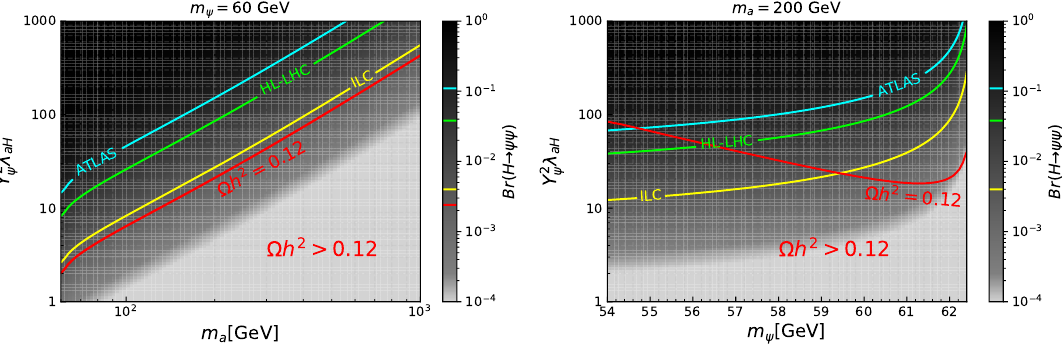
Figure 15. Potential of the current LHC, HL-LHC and the ILC colliders to probe the loop induced branching ratio of Higgs to ψψ for m